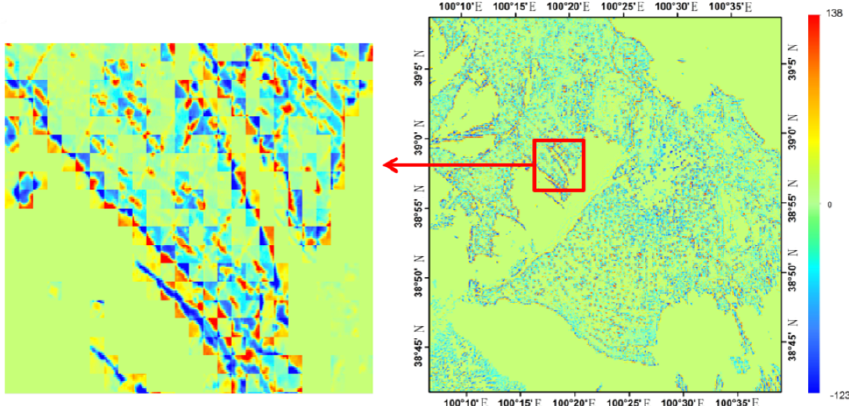
Figure 10. Spatial distribution of the difference AE (dA) and a transition zone on 2 September.